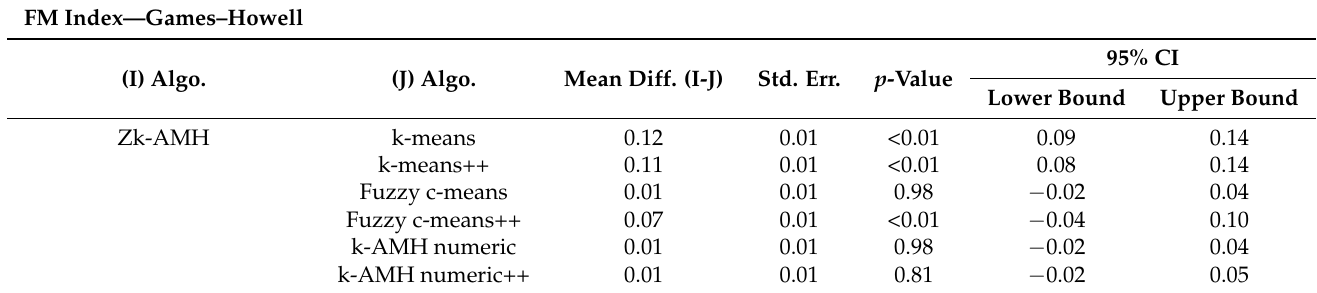
Table 3. Multiple Comparison of the Zk-AMH Algorithm with the other Six Algorithms for a Combined Dataset.